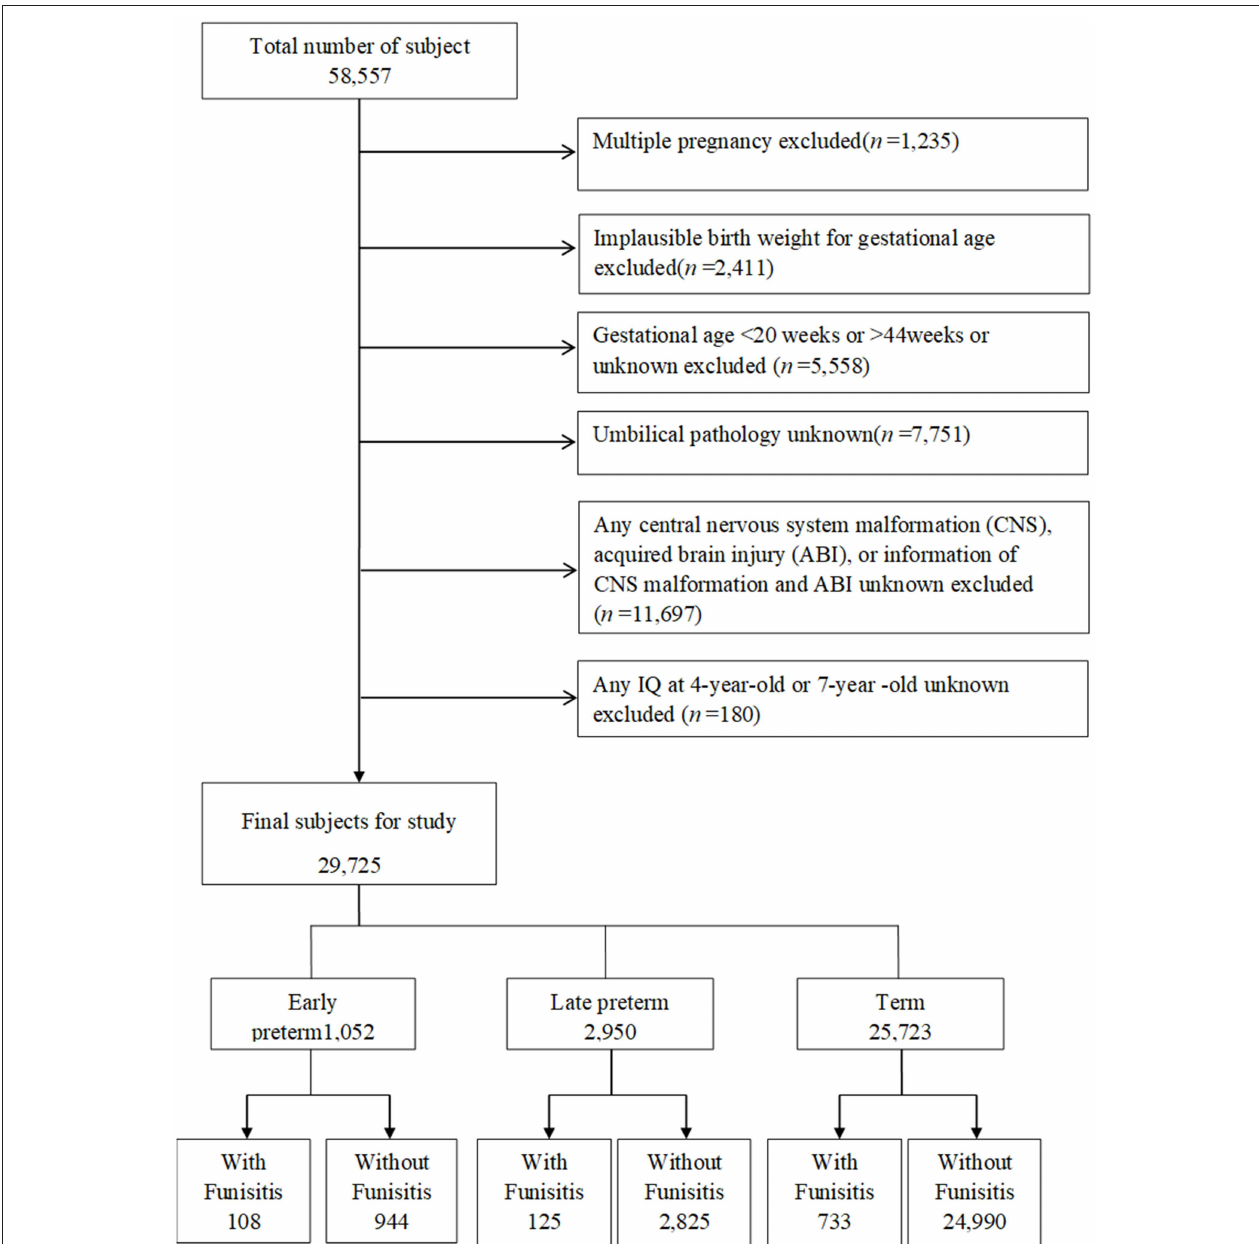
FIGURE 1 | Study flow chart in the selection of study population from the U.S. Collaborative Perinatal Project. Consort diagram of study participants. CNS, central nervous system; ABI, acquired brain